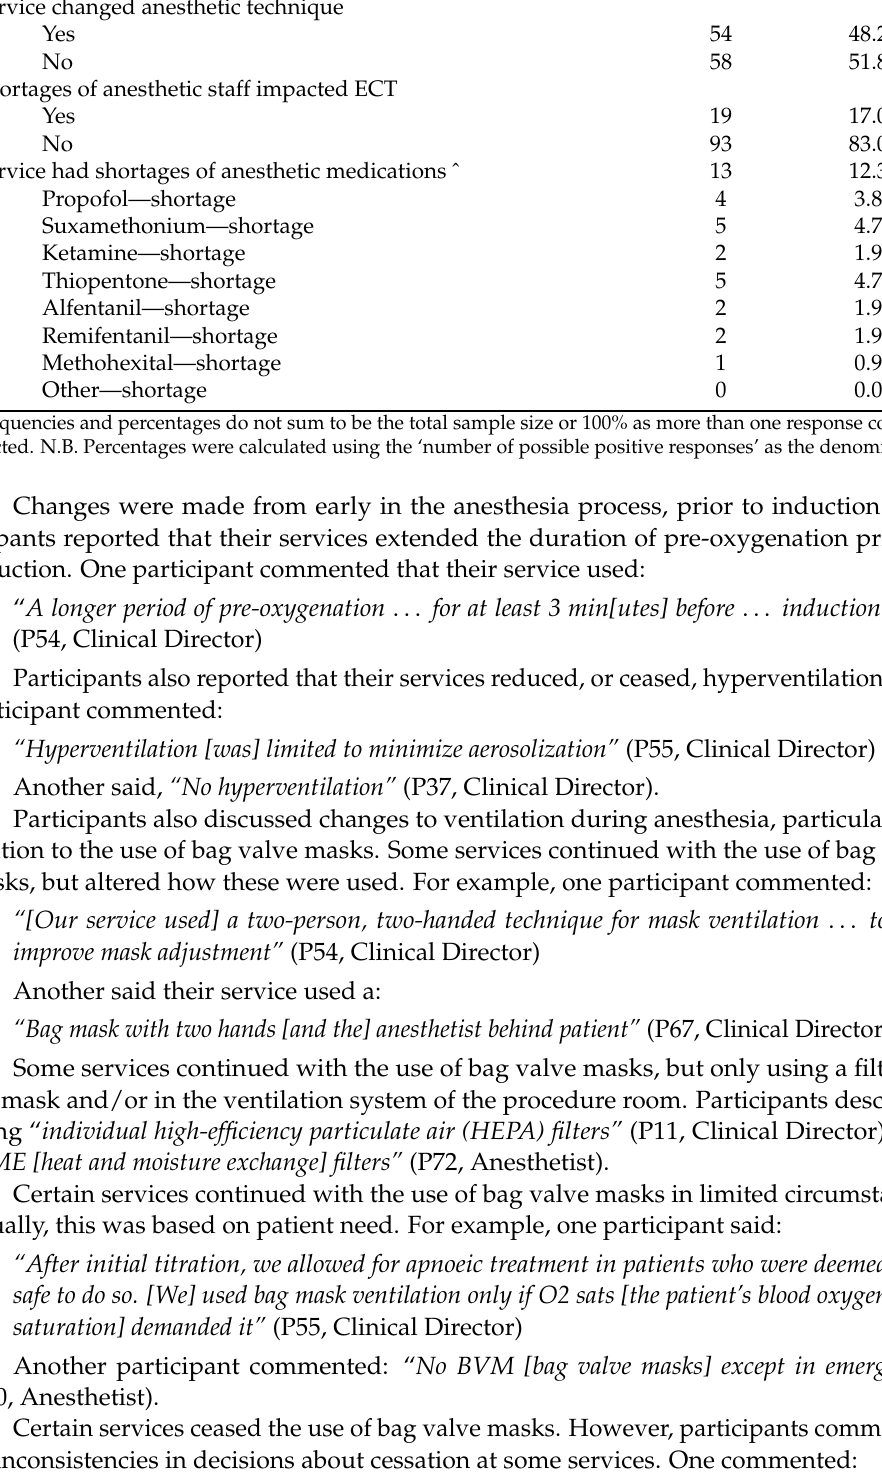
Table 2. Impacts of the COVID-19 pandemic on ECT anesthesia. Impacts of the COVID-19 Pandemic on ECT Anesthesia Service changed anesthetic